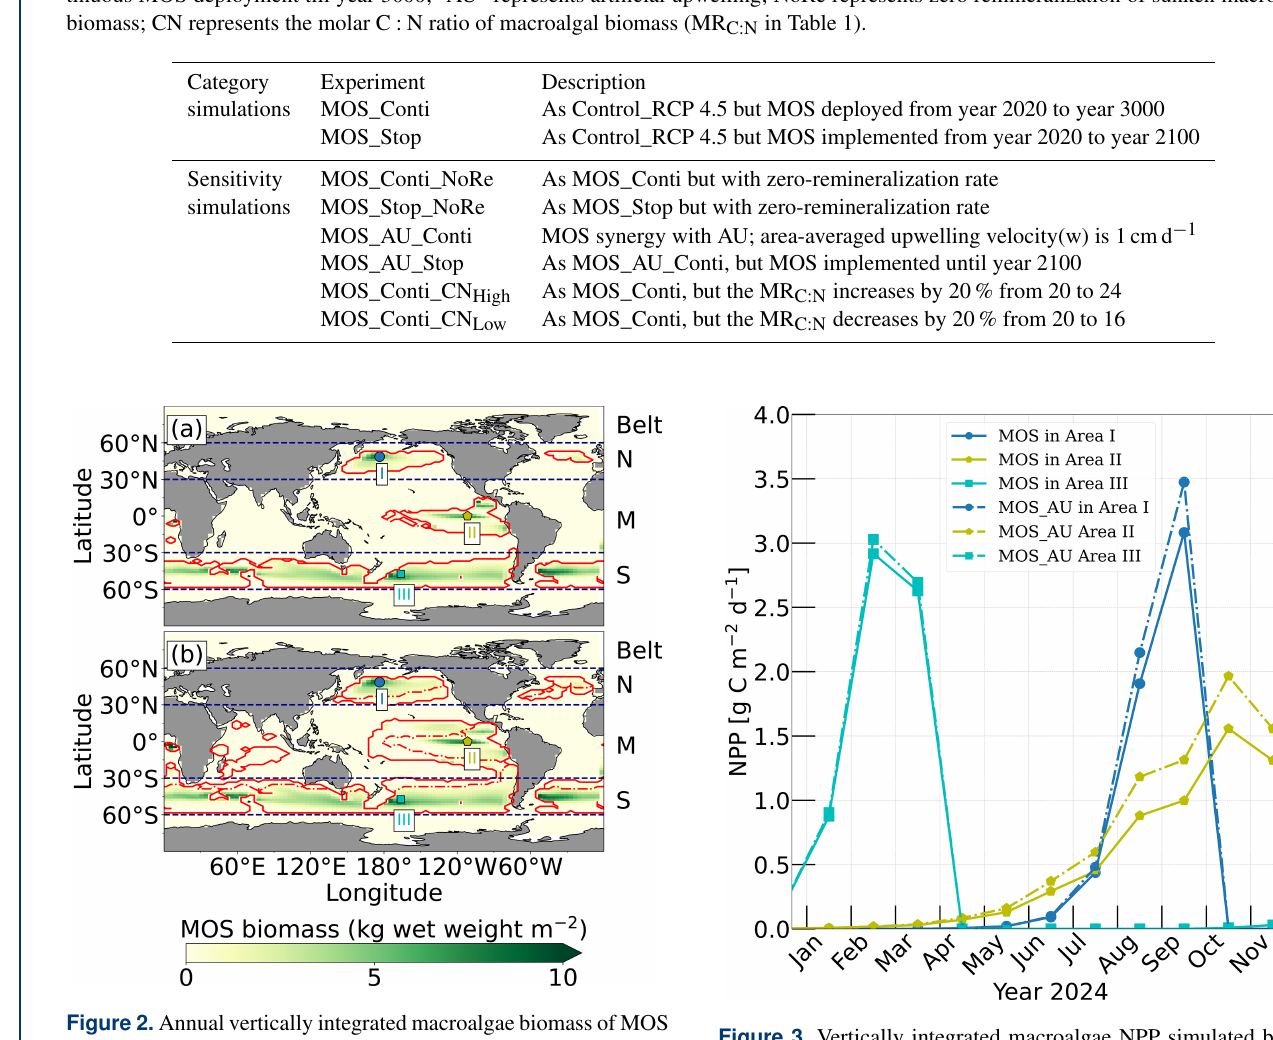
Figure 3. Vertically integrated macroalgae NPP simulated by ex- periment MOS (solid lines) for year 2024 and with representative Areas I (dark blue circle), II (yellow pentagon) and III (cyan rectan- gle) highlighted by rectangles with corresponding colors in Fig. 2. The NPP of macroalgae of experiment MOS_AU (dashed) shows an enhancement of NPP as